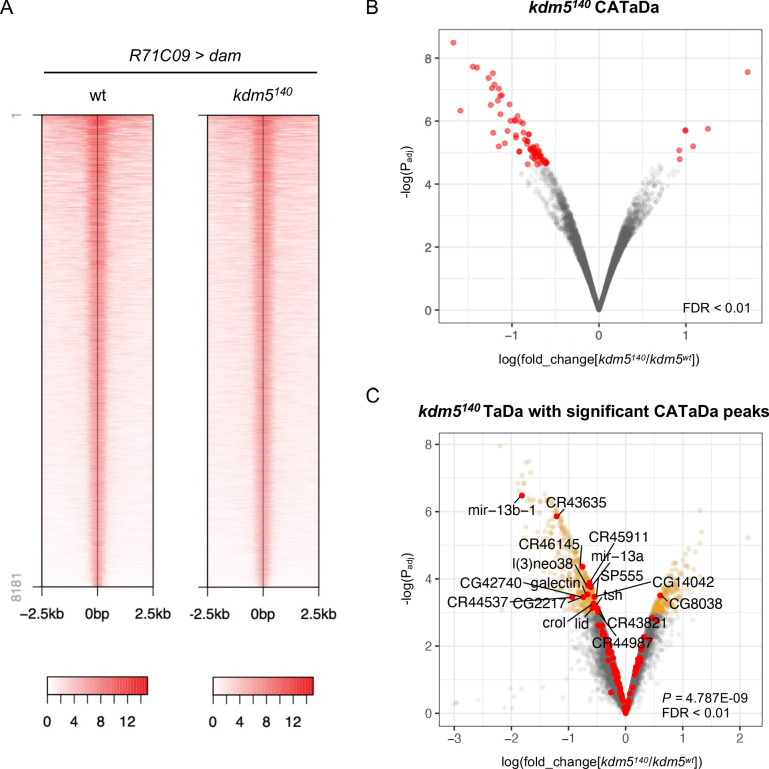
Chromatin accessibility profiling using targeted DamID (CATaDa) analyses reveal minimal changes to chromatin accessibility within ganglion mother cells (GMCs) and immature neurons upon loss of kdm5.(A) Representative CATaDa profiles of R71C09-Gal4 expressing cells for kdm5140 and wild type. Heat maps show Dam binding profiles for the greatest 8181 peaks for each genotype. (B) Volcano plot showing changes to chromatin accessibility within GMCs and immature neurons of kdm5140 animals compared to wild type. Genes with an FDR < 0.01 are in yellow. CATaDa analyses were performed in quintuplicate. (C) Volcano plot showing changes to chromatin accessibility for differentially expressed genes (DEGs) from kdm5140 TaDa. In yellow are kdm5140 TaDa DEGs with an FDR < 0.05. In red are kdm5140 TaDa DEGs with associated changes in chromatin accessibility for FDR < 0.01 (Fisher’s exact test, p=4.79E-09).